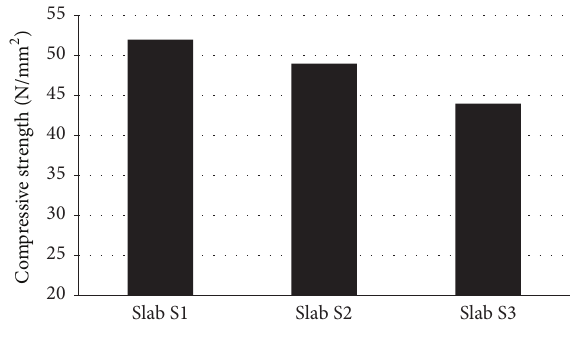
Figure 19: Compressive strength results.